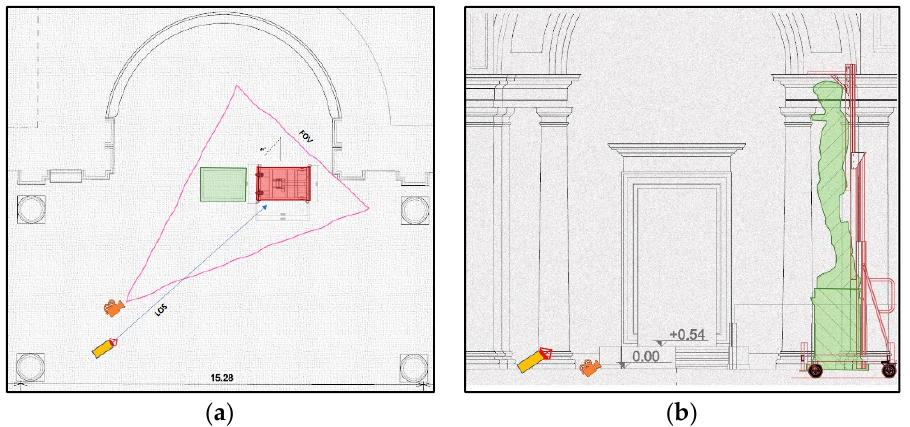
Figure 10. ( a ) Top view map of the study area with camera and radar positions (David in green and gantry in red) that shows the field of view (FOV) of the optical sensor and the line of sight (LOS) of the radar sensor; ( b ) Frontal map of the study area with camera and radar positions, (in green the David and in red the gantry).